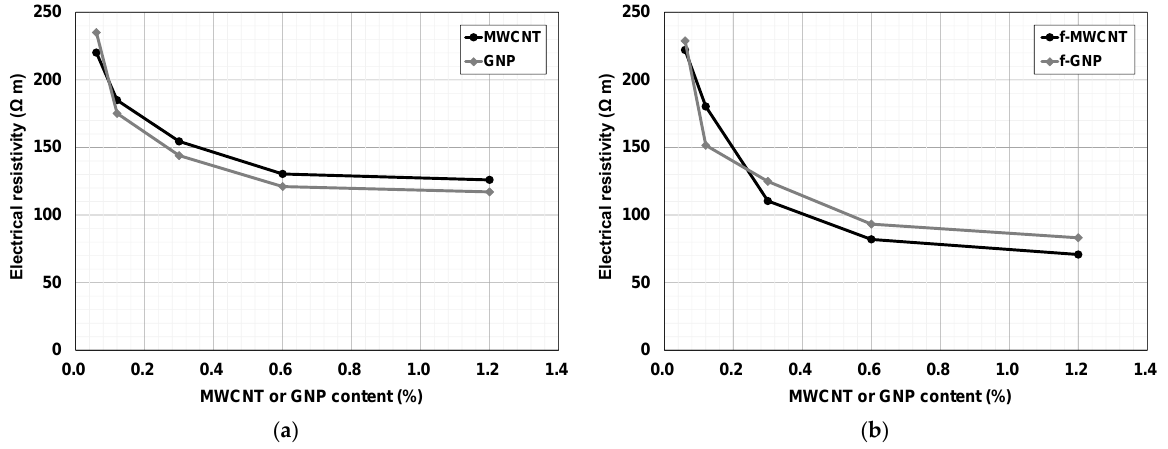
Figure 3. Effect of the MWCNT or GNP content on electrical resistivity: ( a ) non-functionalization and ( b ) functionalization.